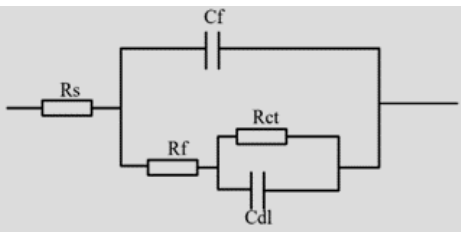
Figure 5. Results of electrochemical impedance spectroscopy of copper immersed in acetic acid solution for different time.